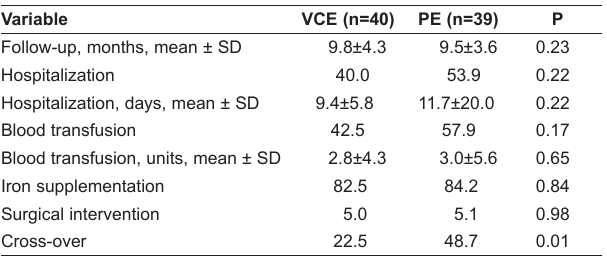
TABLE 4 Health resource utilization